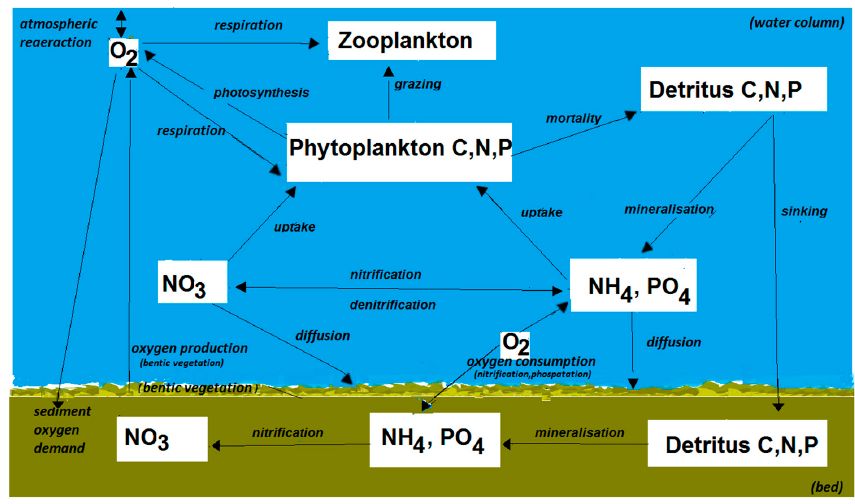
Figure 2. The conceptual diagram for the eutrophication model.